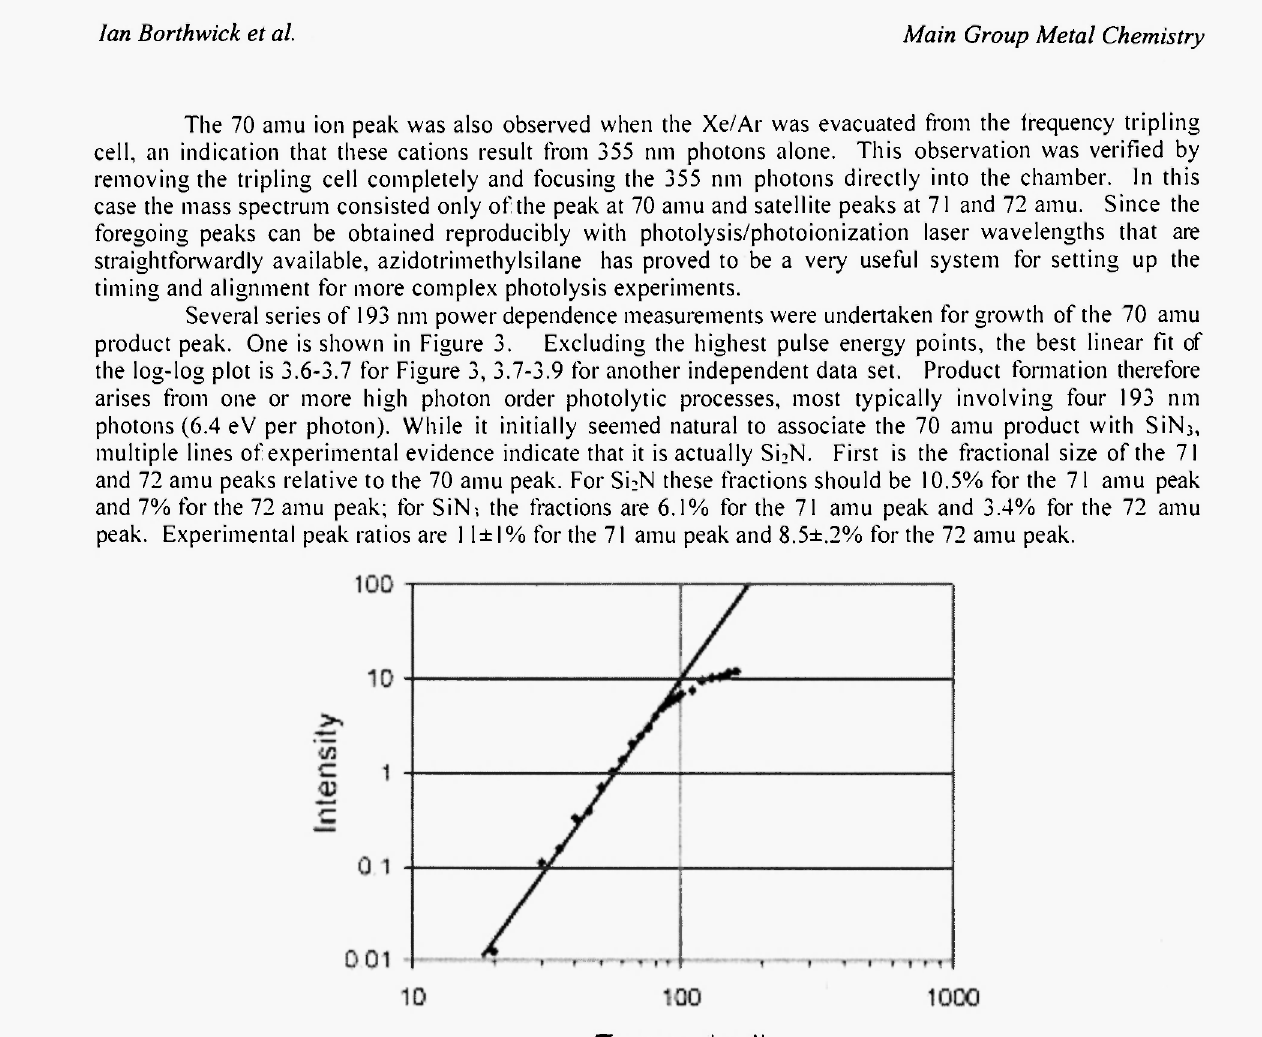
Figure 3. Log(intensity) versus lo«(pulse energy) dependence of the 70 amu product peak for 193 nm photolysis of azidotrimethylsilane with subsequent 118 nm photoionization. There are no complications